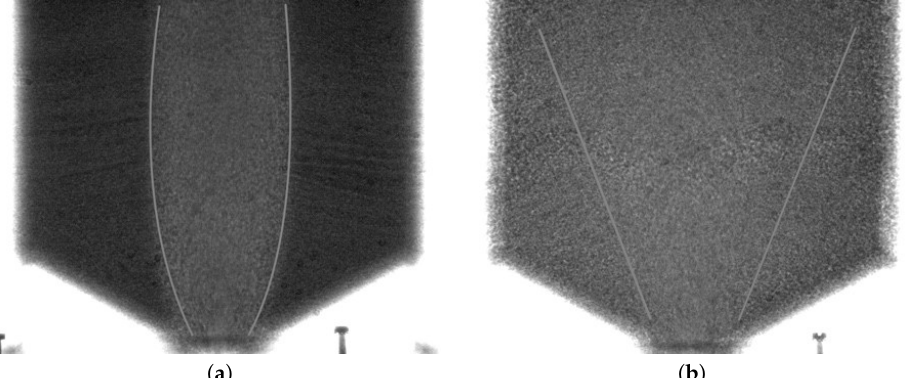
Figure 2. Radiography images of funnel flow in the silo: ( a ) initially dense packing; ( b ) initially loose packing. Contour lines indicate approximate flow funnel